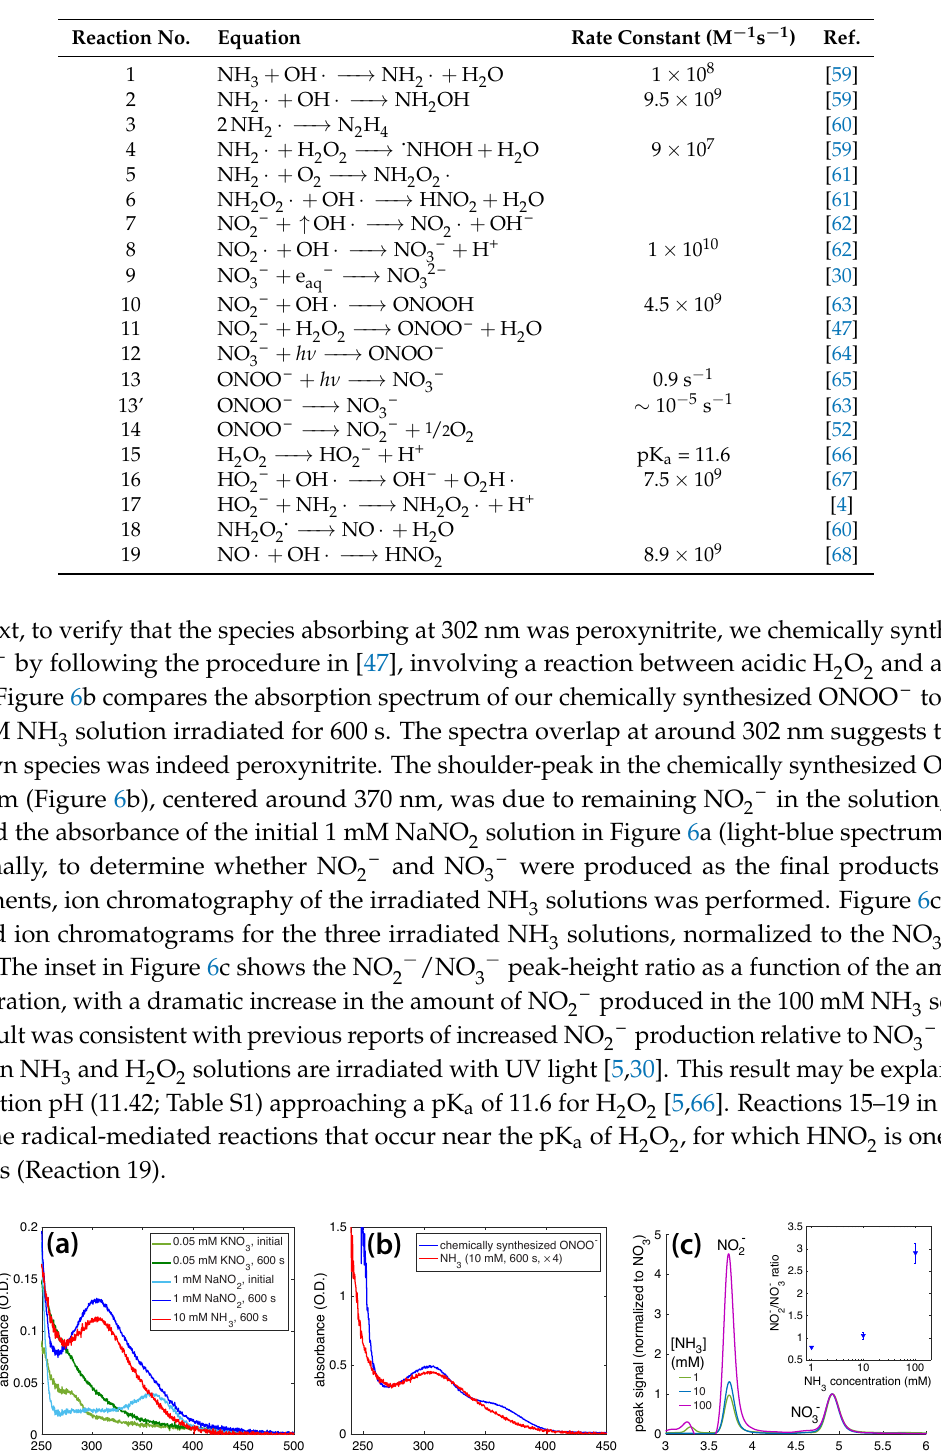
and NaNO solutions, with irradiated 3 2 and chemically synthesized ONOO – ; 3 solutions irradiated for 600 s. Peak heights 3 /NO − peak-height ratio as a function of 2 3